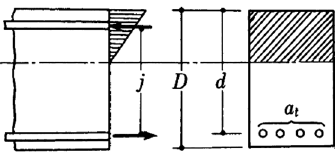
Figure 4. Flexural strength calculation of the beam component according to the RC and WRC Standards [3,4].